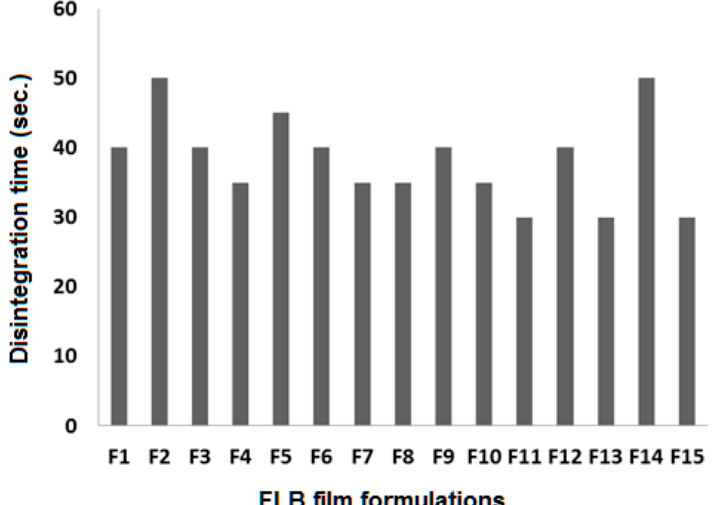
Figure 8. Disintegration times for FLBFDOF formulation.